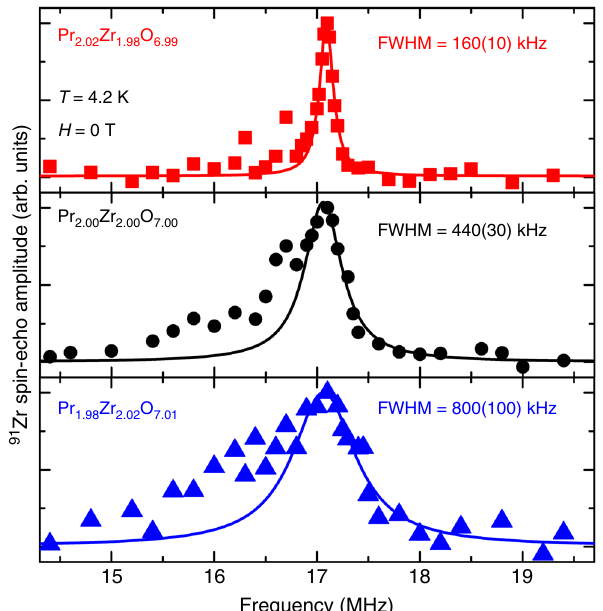
Fig. 4 91 Zr Nuclear Quadrupole Resonance data for the series Pr 2 + x Zr 2 − x O 7 − x /2 . Experimental data is shown as red squares ( x = 0.02), black circles ( x = 0), and blue triangles ( x = − 0.02). Solid lines represent Lorentzian fi ts with respective full-width half maxima (FWHM) shown. Lorentzian fi ts are poorer for x = 0 and x = − 0.02 due to asymmetric peak shapes. Size of the symbols represents standard uncertainties given by the scatter of the